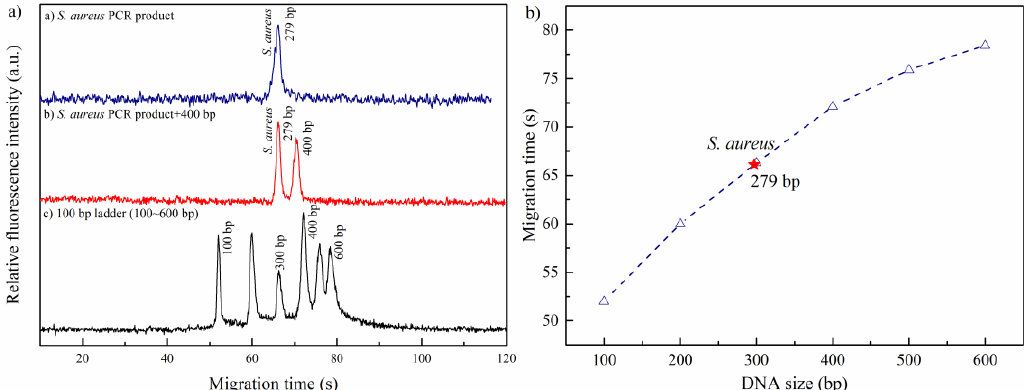
Figure 3. ( a ) Identification for the PCR products of nuc gene; ( b ) the plot of DNA size versus migration time (the red star represents the PCR product of S. aureus ). The electrophoresis was performed in 1% HEC (1300 K) at 800 V.